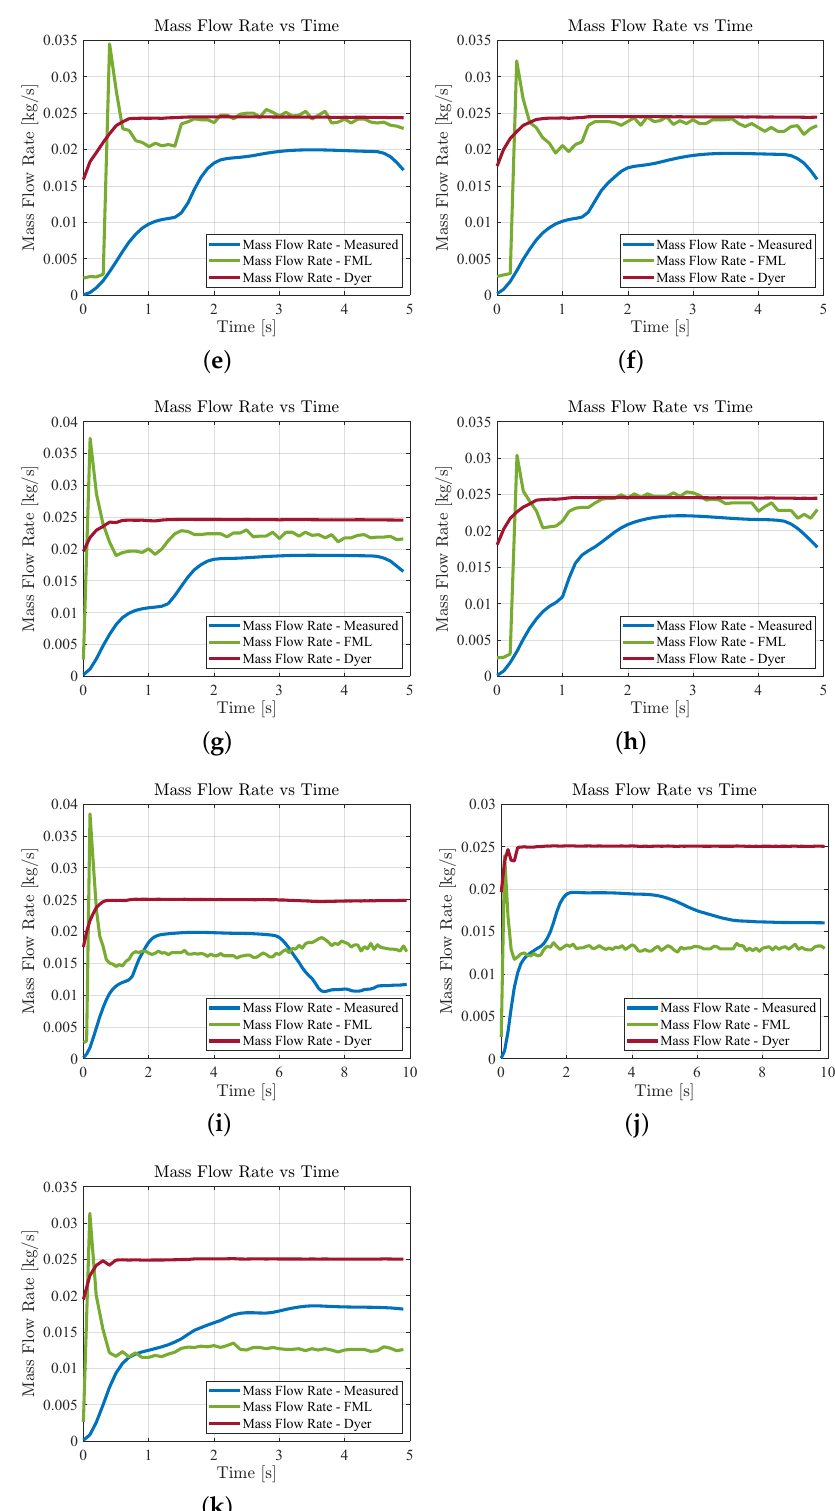
Figure 6. Comparison between the experimental mass flow rate and the one predicted from the FML and Dyer’s model, for the first experimental